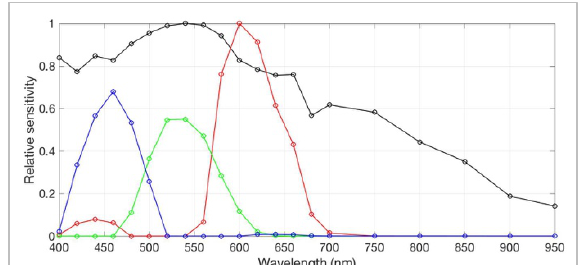
Figure 10. Normalised spectral response for the unmodified and modified camera. The unmodified camera is represented by the blue, green, and red lines for the 3-channels of the camera; and the modified camera is represented by the black line.